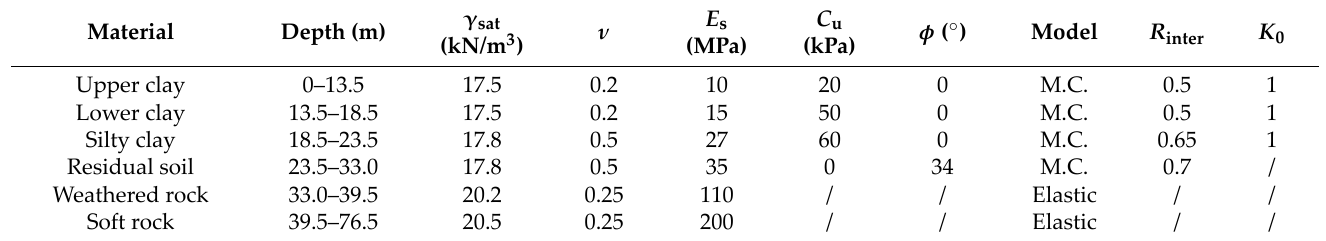
Table 2. Material properties adopted in the numerical model (Reprinted from [20] with permission from